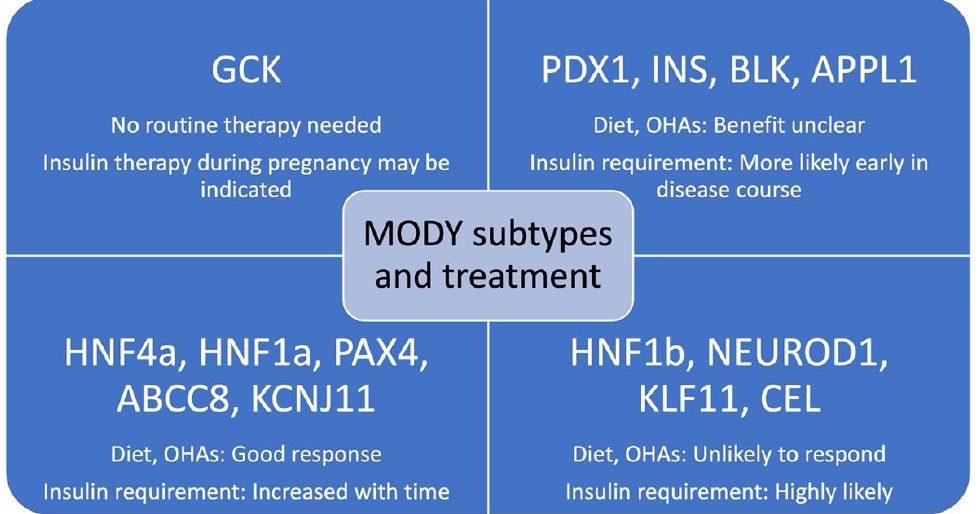
Figure 1. MODY subtypes and pharmacologic treatment options. OHAs = oral hypoglycemic agents; GDM = gestational diabetes mellitus. [47,119–129].